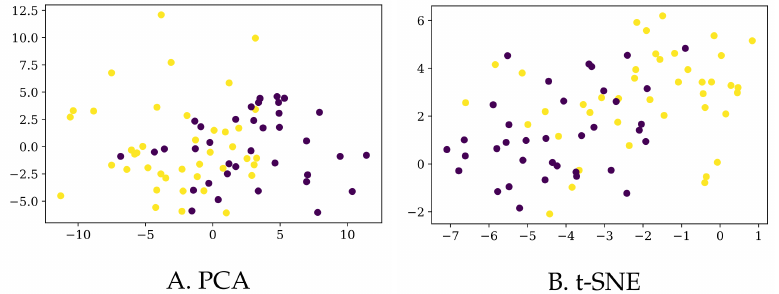
Figure 3. A 2D representation of the original data (77 points in R 126 ); in yellow, positive examples (PD patients), in purple, negative examples (participants in the HC